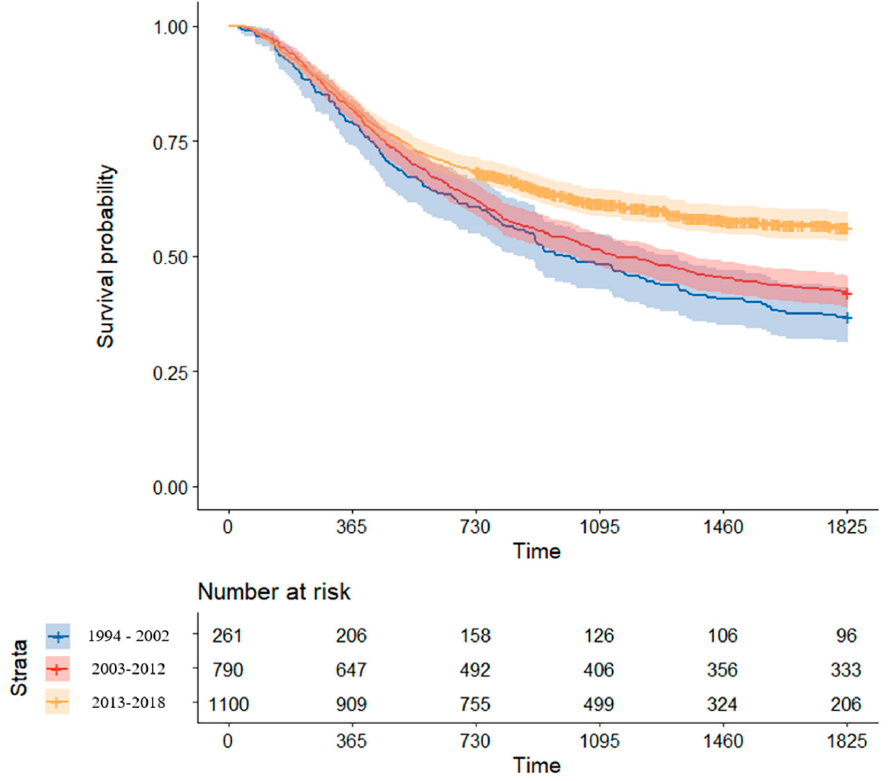
Figure 4. Comparison of Kaplan–Meier survival curve by treatment period.